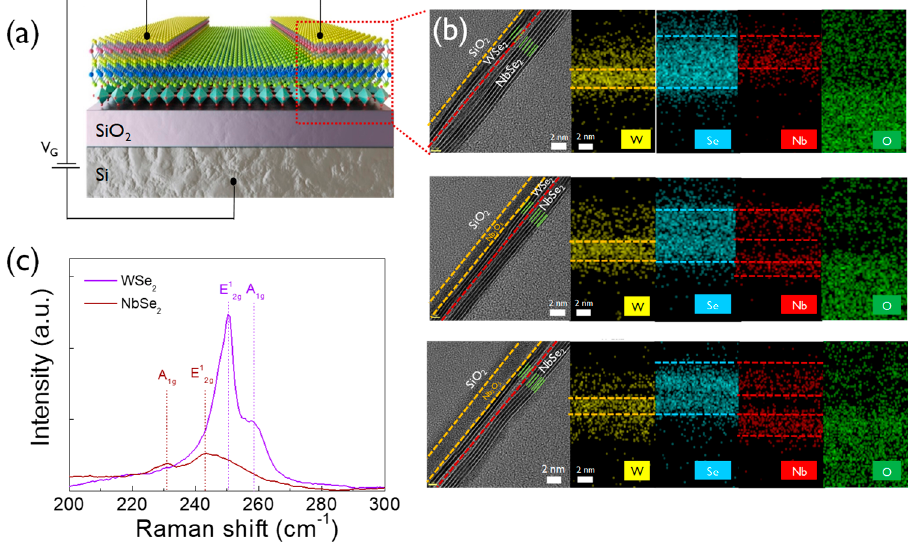
Figure 2. ( a ) Configuration scheme for the electrical measurements of the synapse transistor device. ( b ) Cross-sectional high-resolution transmission electron microscopy and energy-dispersive X-ray spectroscopy (EDS) elemental mapping images recorded from WSe 2 -NbSe 2 , 2.6 nm Nb 2 O 5 -WSe 2 -NbSe 2 and, 3.9 nm Nb 2 O 5 -WSe 2 -NbSe 2 ( c ) Raman spectra for WSe 2 , and NbSe 2 that serve as the active channel and metallic electrode, respectively.